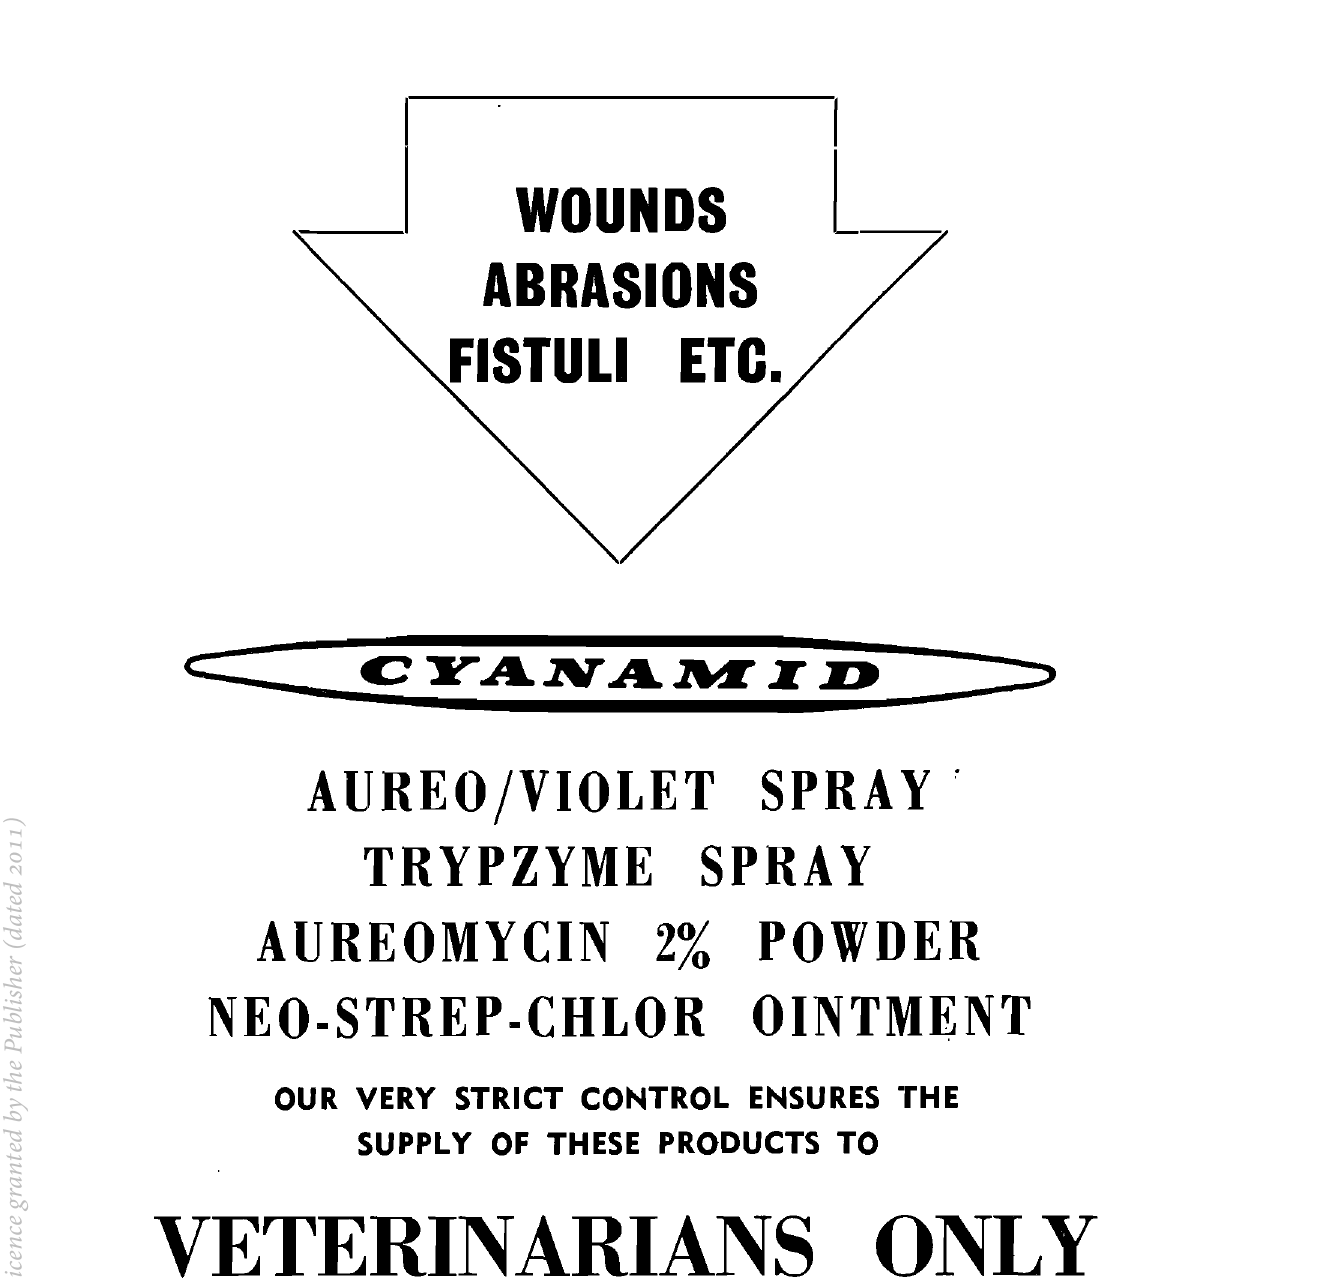
AUREOjVIOLET SPRAY~ TRYPZYME SPRAY AUREOMYCIN 2% POWDER NEO·STREP·CHLOR